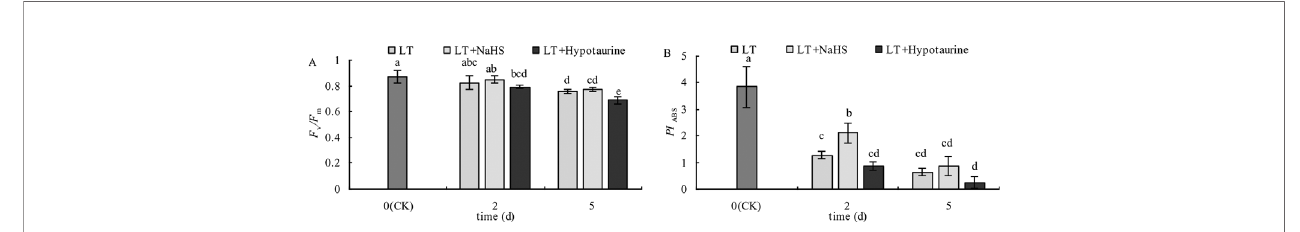
FIGURE 3 | Effects of exogenous NaHS and Hypotaurine on F v / F m (A) and PI ABS (B) of blueberry leaves under low temperature stress. The data in the fi gure are from fi ve replicated experiments (n = 5), and represent means ± standard error (SE). Different small letters show signi fi cant differences ( P < 0.05).CK: room temperature control at 25°C; LT: low temperature treatment; LT + NaHS: low temperature treatment at 4 – 6°C after spraying 0.5 mmol·L – 1 NaHS; LT + Hypotaurine: low temperature treatment at 4 – 6°C after spraying leaves with 200 m mol·L –